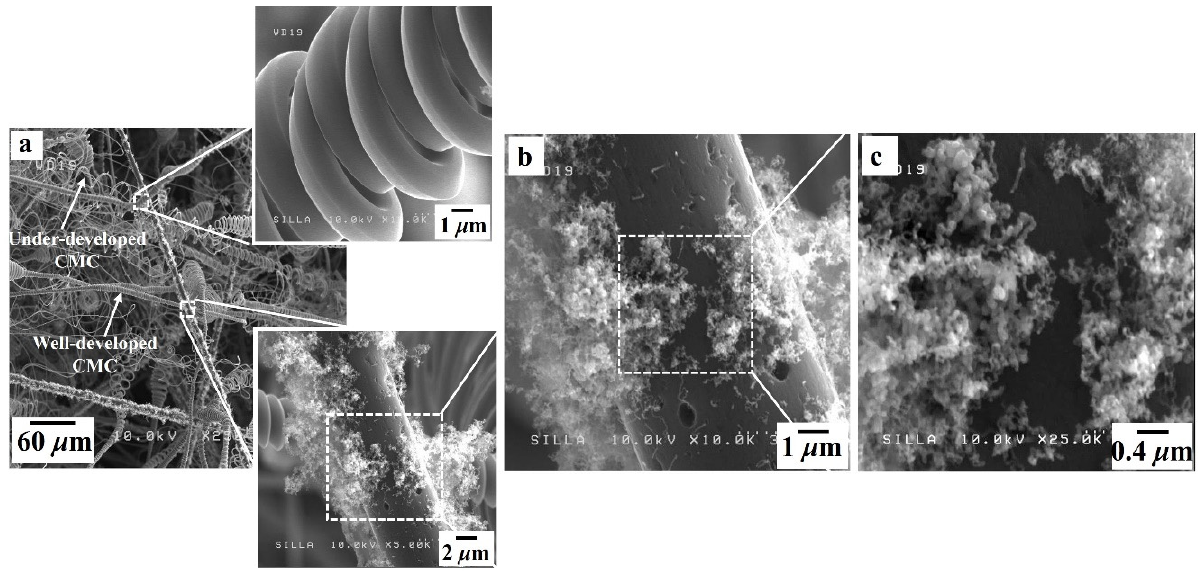
Figure 5. ( a ) FESEM images of sample C, ( b ) magnified FESEM image of the lower inset in Figure 5a, and ( c ) high magnification FESEM image of Figure 5b. The upper and lower insets in Figure 5a show the surfaces of CMCs and i-CFs, respec- tively.